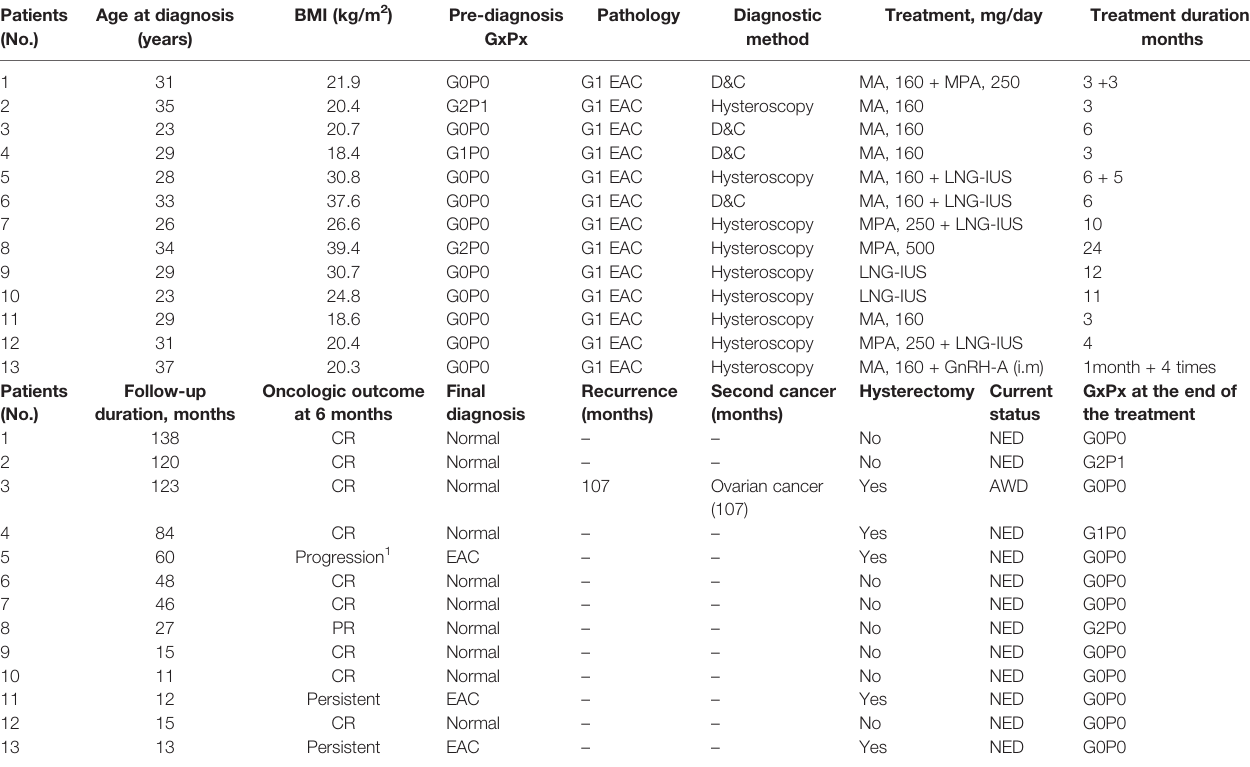
TABLE 3 | Demographics, clinical – pathological characteristics, treatment, oncologic outcomes of the EC patients who underwent FPT. Patients